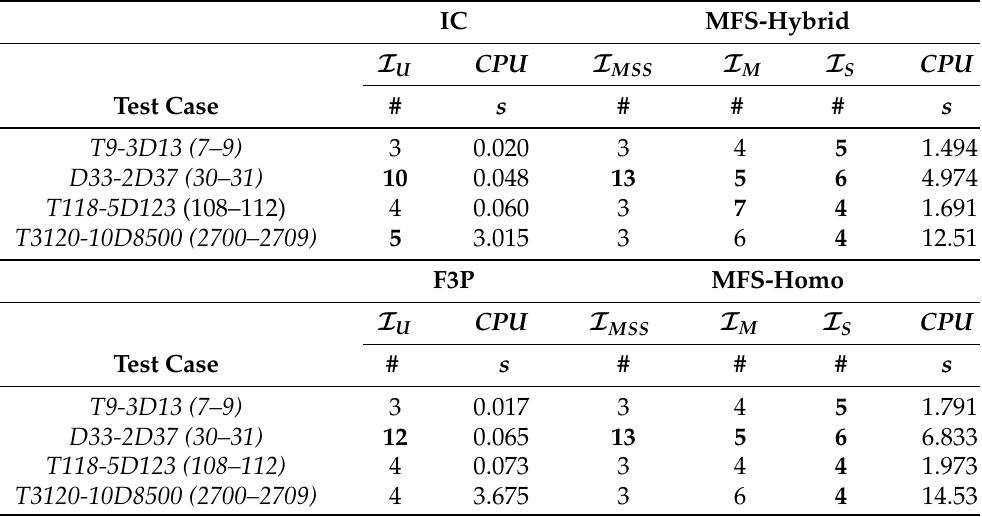
Table 7. Comparison on number of iterations and CPU time of the integration methods, applied to the test cases having multiple distribution feeders connected. The change in iteration number, compared to the original networks, are